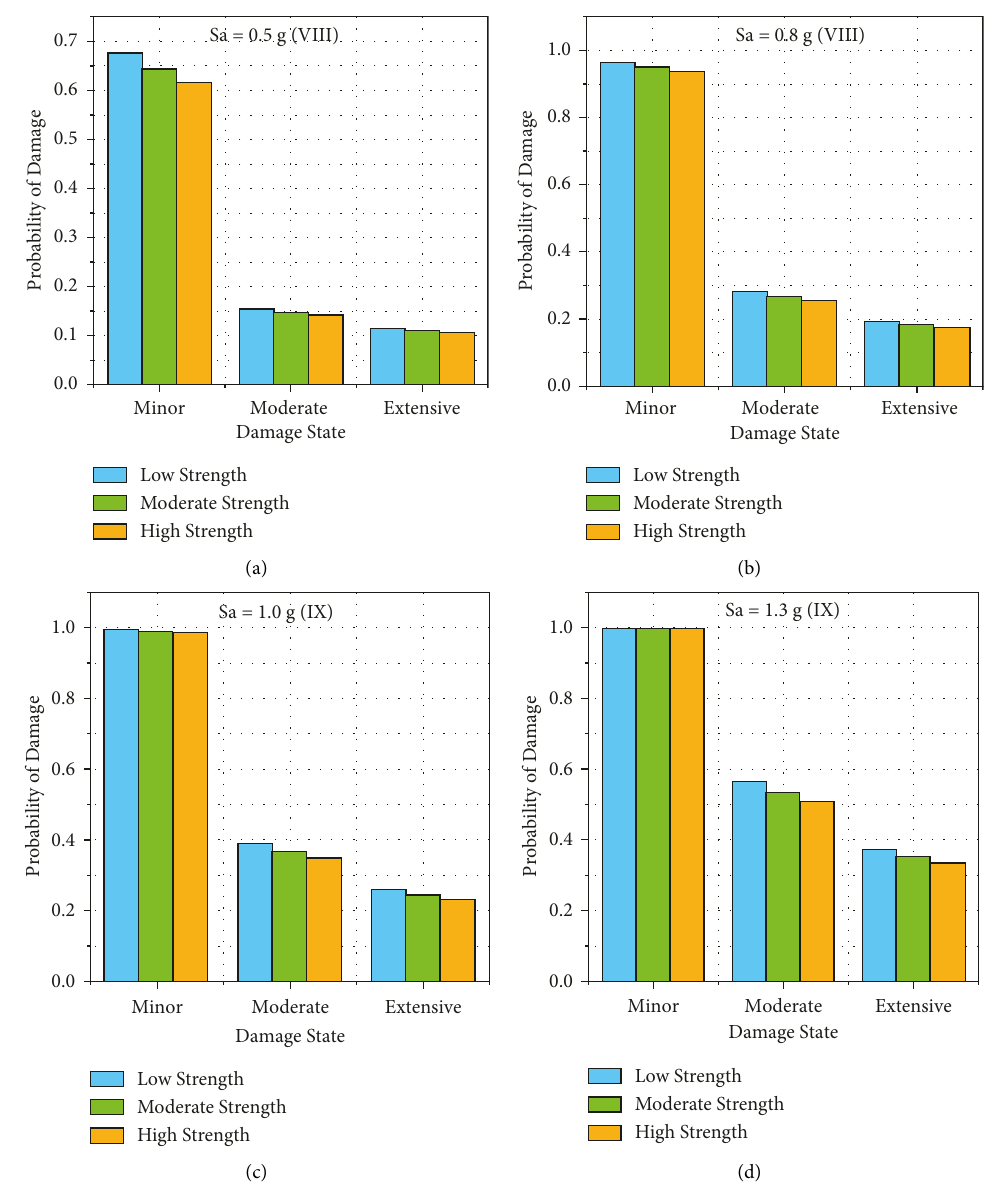
Figure 4: Damage probability for roads with different pavement strength (P2) for various damage states and seismic